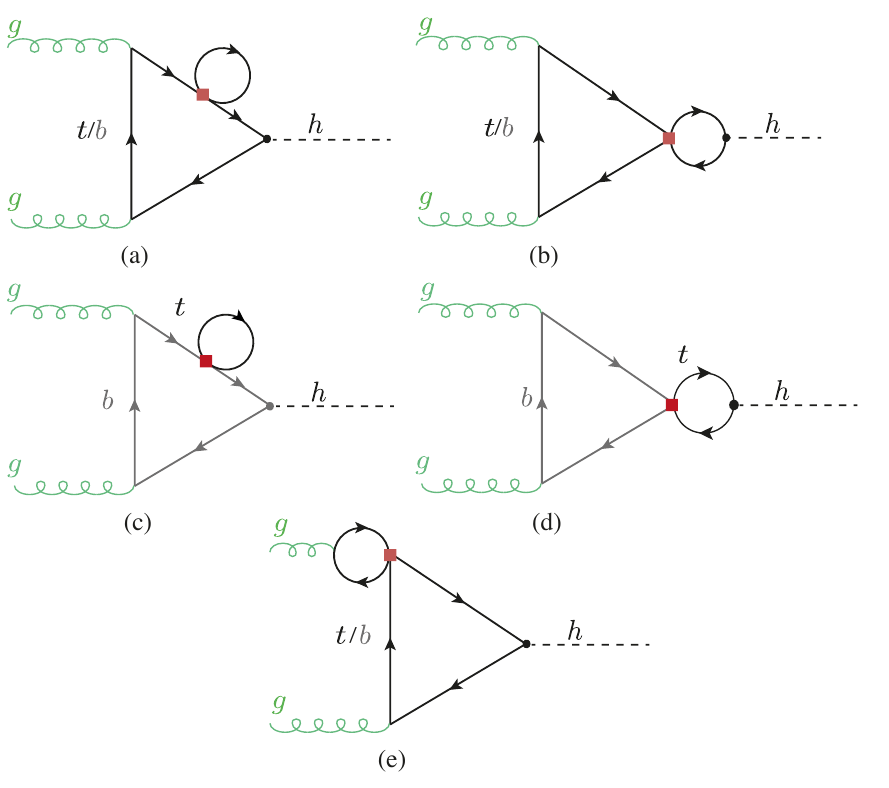
Figure 1 . Example Feynman diagrams for four-fermion-operator contributions to the Higgs pro- duction via gluon fusion. The red box indicates the four-fermion